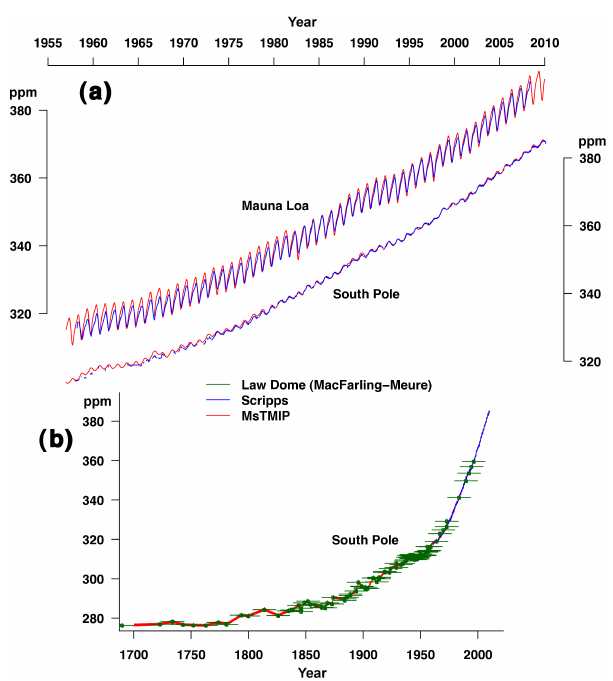
Figure 5. Comparison of MsTMIP driver data atmospheric CO 2 with independent data. (a) Comparison of MsTMIP and Scripps CO 2 program data at Mauna Loa and South Pole from 1958 to 2010, and (b) comparison with Law Dome ice core records of atmospheric CO 2 (MacFarling Meure et al.,